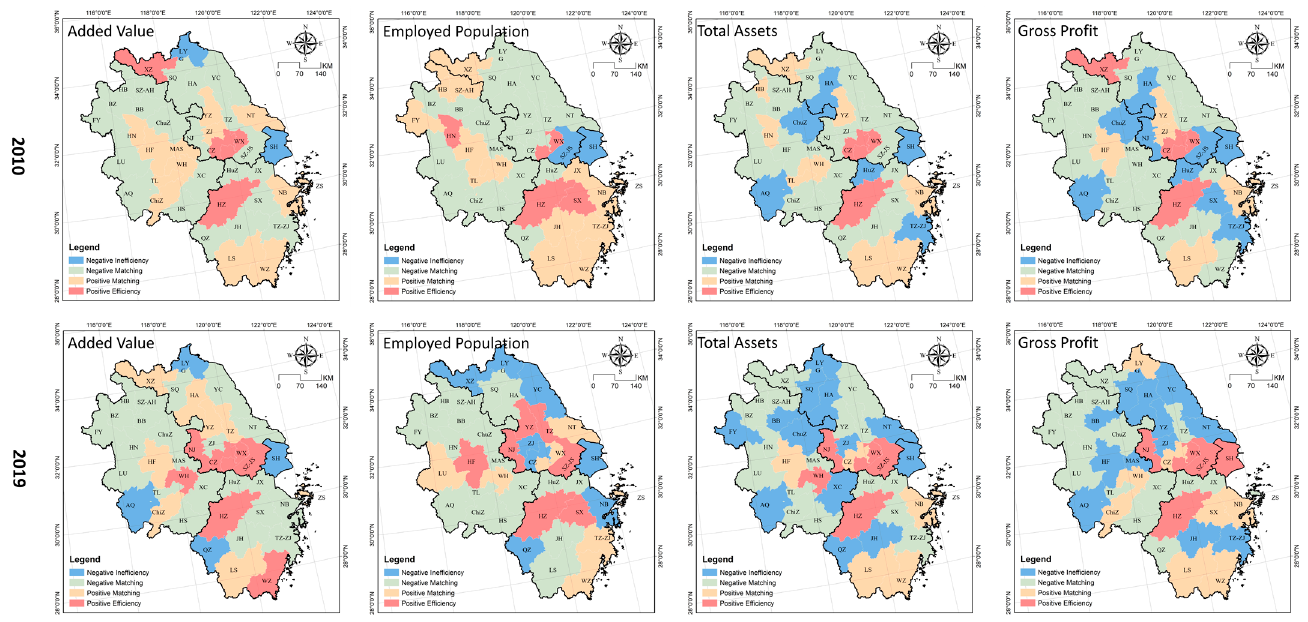
Figure 10. Analysis of the spatial mismatch types in the YRD.